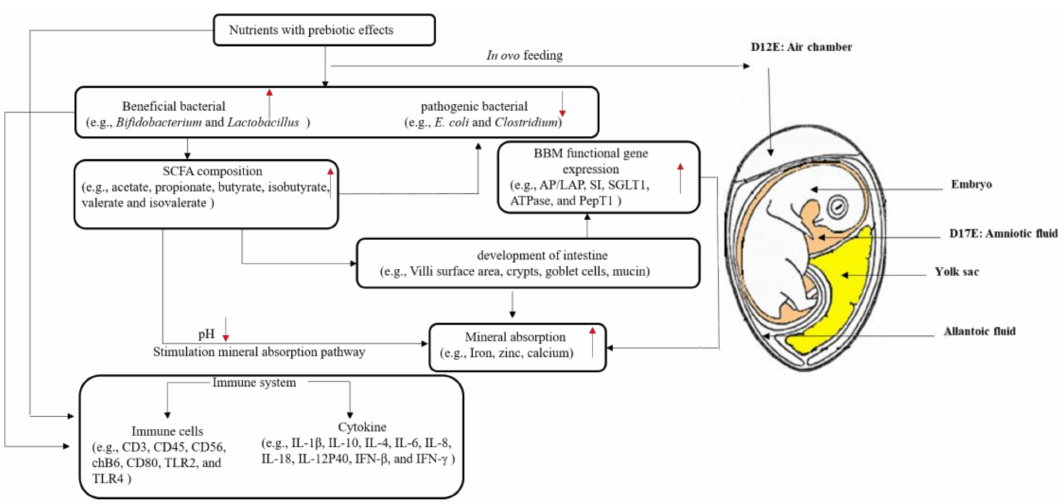
Figure 1. Schematic diagram depicting proposed mechanisms by which the in ovo feeding approach of nutrients with prebiotic properties may affect the Gallus gallus developing embryo. Processes described as follows: post in ovo administration, the gut bacterial populations are affected, mostly as the beneficial bacterial population’s increase (1). The increase of beneficial bacterial (such as Bifidobacterium and Lactobacillus ) promote the production of short-chain fatty acids (SCFA) (2). The increased production of SCFA due to bacterial activity leads to a luminal pH reduction (3); moreover, intestinal morphology (such as villi height, crypts, goblet cells, and mucin) is affected (4), and the mineral absorption (iron, zinc, and calcium) is increased due to their pH reduction and their increased solubility (5). The morphological affects (increased villi surface area and goblet cell numbers) can potentially stimulate the intestinal functional genes expressions, primarily proteins that are required for intestinal mineral absorption. In addition, the in ovo prebiotic administration seemed to affect the immune system (6). Black arrow: the relationship between two factors; red arrow: increased or decreased levels. Injection target: the injection site is air chamber at Day 12 (D12;) the injection target is amniotic fluid at D17. BBM: Brush Border Membrane; AP: Aminopeptidase; LAP: leucine aminopeptidase; SI: Sucrase-isomaltase; SGLT1: Sodium glucose transporter 1; PepT1 peptide transporter 1; TLR: toll-like receptor; IL: interleukin; IFN: interferon; ATP: adenosine